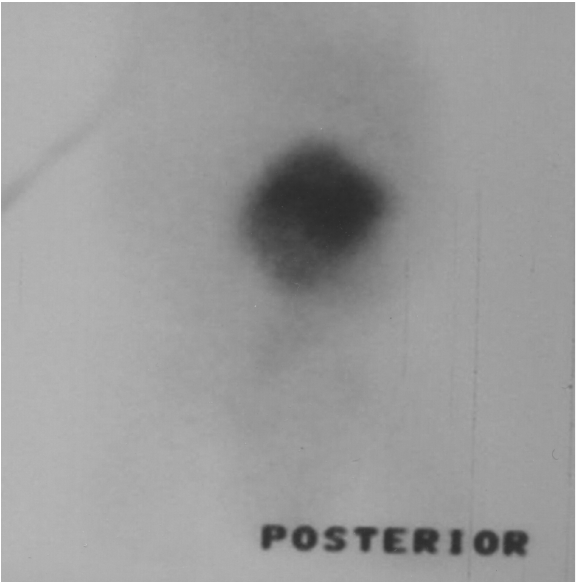
Figure 1 – Renal scintigraphy (DTPA) showing a single renal mass with radiopharmaceutical